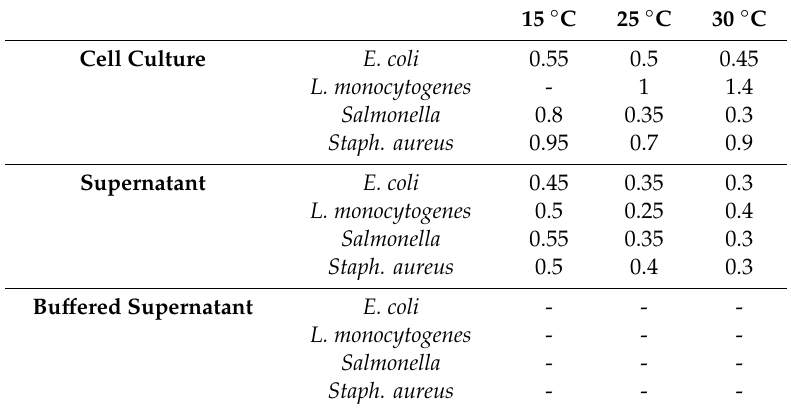
Table 2. Inhibition halo ([Halo]–[well diameter]) of Lb. plantarum 178 towards pathogens. The data are the average of three repetitions. -, no